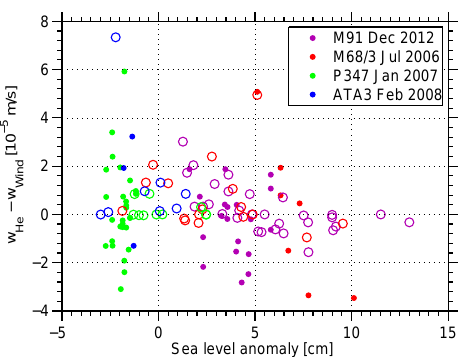
Figure 6. Difference between helium- and wind-derived vertical ve- locity against sea level anomaly at each station for the coastal (filled circles) and offshore (open circles) region of cruises M91, M68/3, P347 and ATA3. Note that the uncertainty of the helium-derived up- welling velocities is 68% for the Peruvian and 100% for the Mau- ritanian